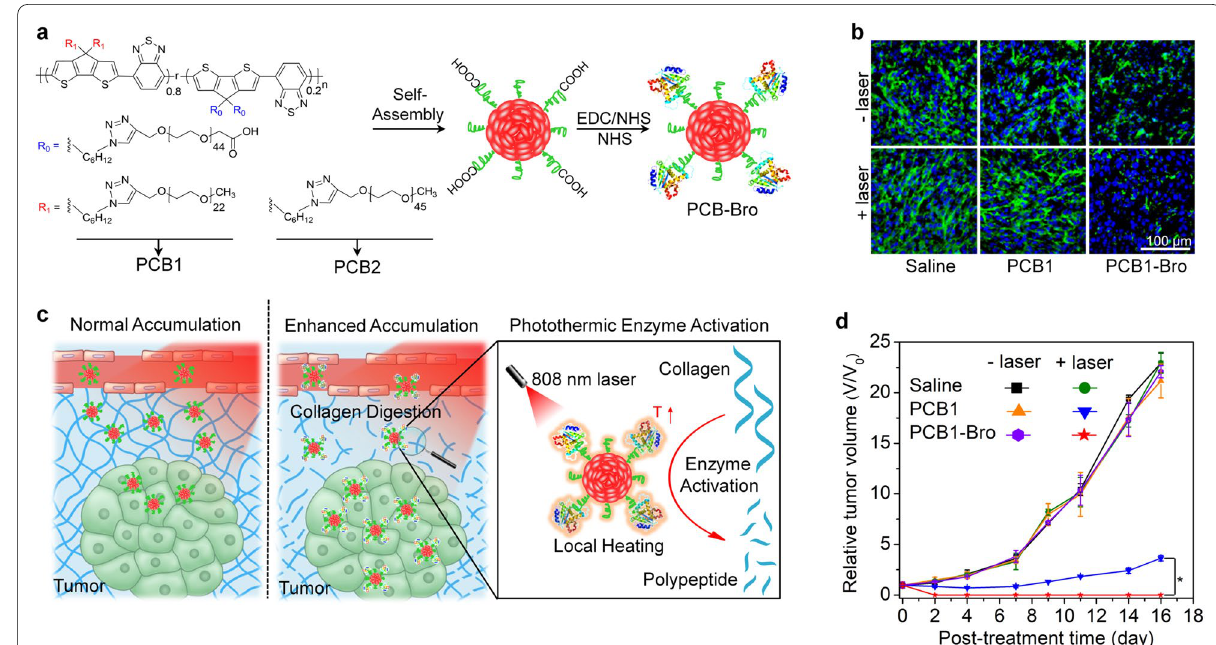
Fig. 4 a Chemical structures of PCB1 and PCB2 and schematic for the synthesis of PCB-Bro. b Immunofluorescence collagen I staining images of 4T1 tumors after intratumoral injection of saline, PCB1, or PCB1-Bro with or without laser irradiation. Cell nucleus were stained by 4 ′ ,6-diamidino-2-phenylindole (DAPI) and collagen I was stained by Alexa Fluor 488 conjugated anti-collagen I antibody. c Illustration of photothermally triggered enzyme activation of PCB1-Bro towards collagen digestion for enhanced accumulation of nanoparticles in tumors. d Tumor growth curves of 4T1 tumor-bearing mice in different groups. Reproduced with permission from [59]. Copyright 2018,